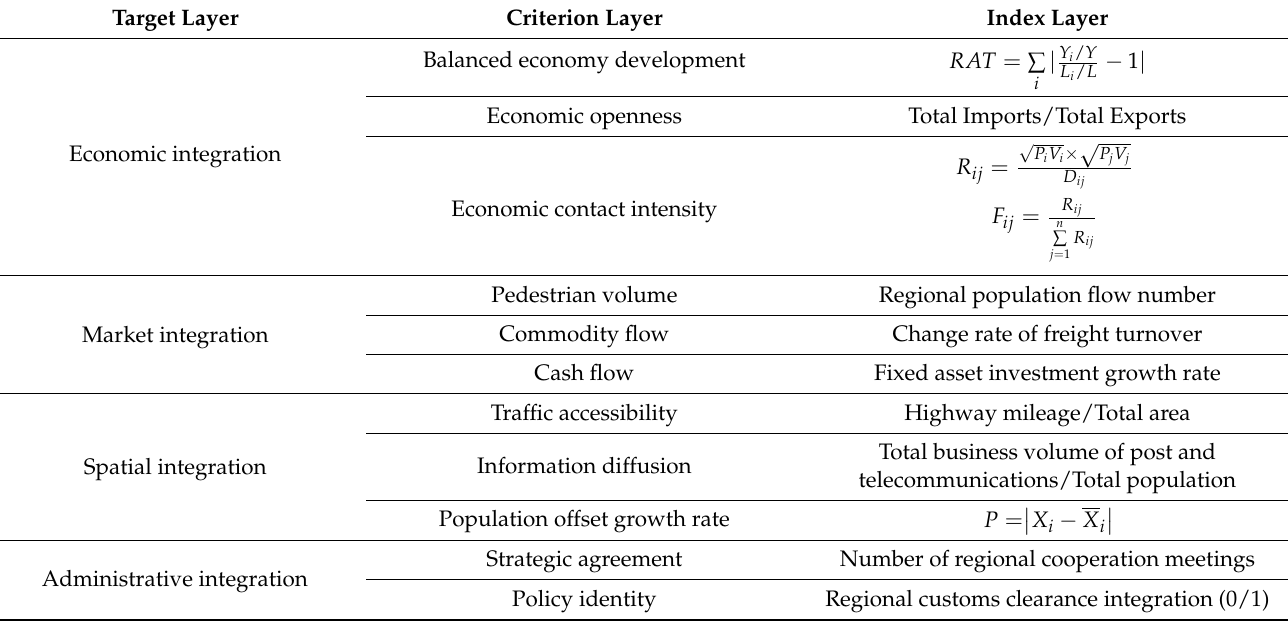
Table 2. Indicators system of regional